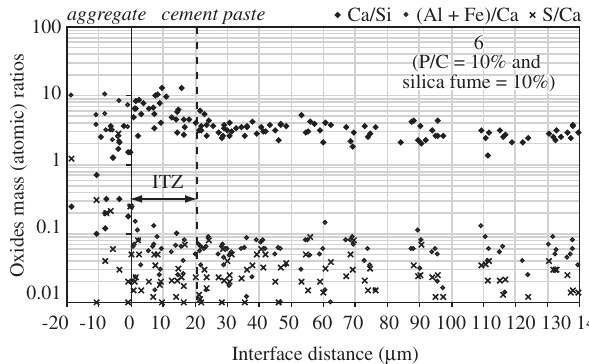
Figure 7. The ratios of Ca/Si, (Al + Fe)/Ca and S/Ca to concrete 5 (P/C = 10% and S/C=10%).